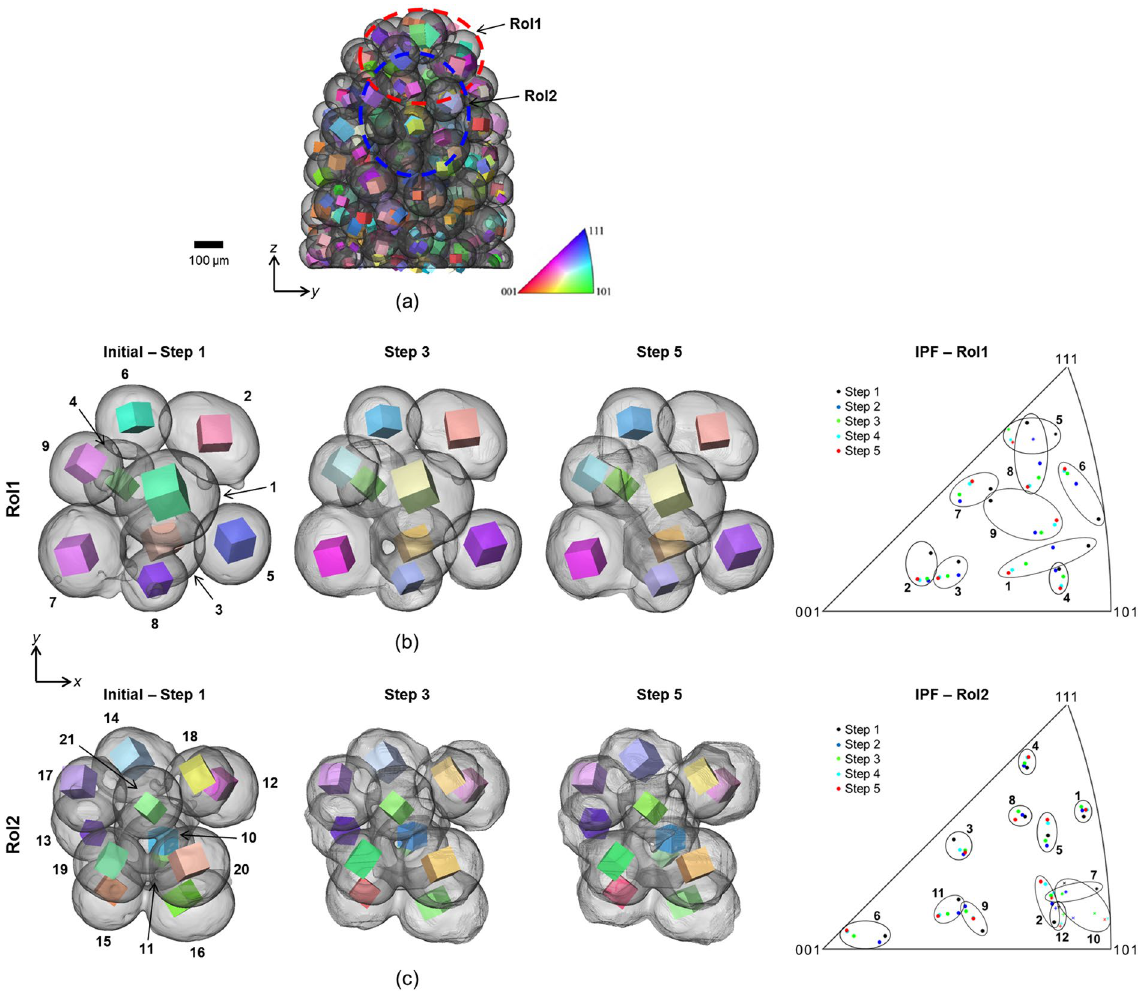
Figure 2. Particle rotations extracted from changes in crystallographic grain orientation during sintering at 1050 °C. ( a ) The absorption CT volume (transparent black and white 3D surface) of the copper particle sample and the associated LabDCT grain map reconstruction, for the initial sintering step. Crystal grains from the LabDCT analysis are represented as cubes centred on their measured (x,y,z) positions, revealing their crystallographic orientation (by colour according to inverse pole figure). The cubes are scaled by 0.5 according to the respective grain size. ( b ), ( c ) Two plan view image sequences showing the two local regions of interest (clusters, RoI1 and RoI2) have been extracted for further analysis; their locations with respect to the sample are indicated in ( a ) and in Fig. 1. The grains in each RoI are also shown plotted on an inverse pole figure (colour according to the IPF colourmap in ( a )) to show their angular movements.